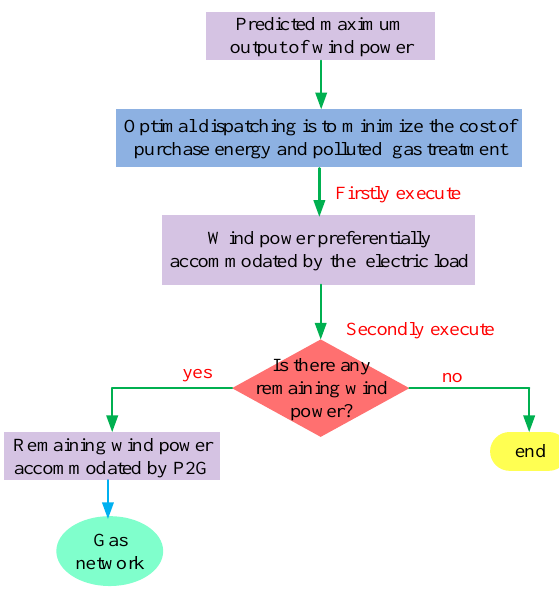
Figure 5. Combined Electro-Gas Bi-Directional Conversion System (CEGBCS) accommodate wind power by optimization.